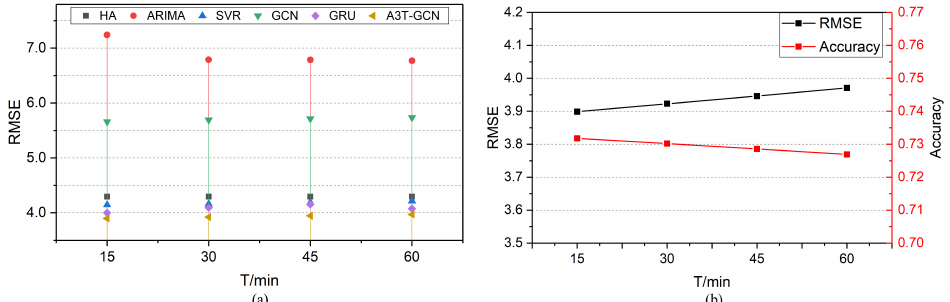
Figure 4. SZ-taxi: Long-term prediction ability. ( a ) The RMSE of the A3T-GCN and baselines under different prediction horizons. ( b ) The changes in RMSE and accuracy of the A3T-GCN under different prediction